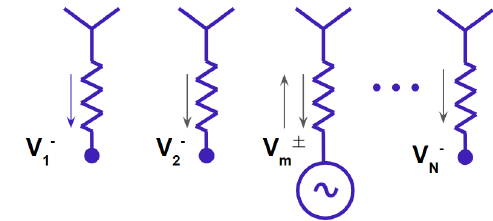
FIGURE 10: Schematic view of array of N elements with only m th element excited